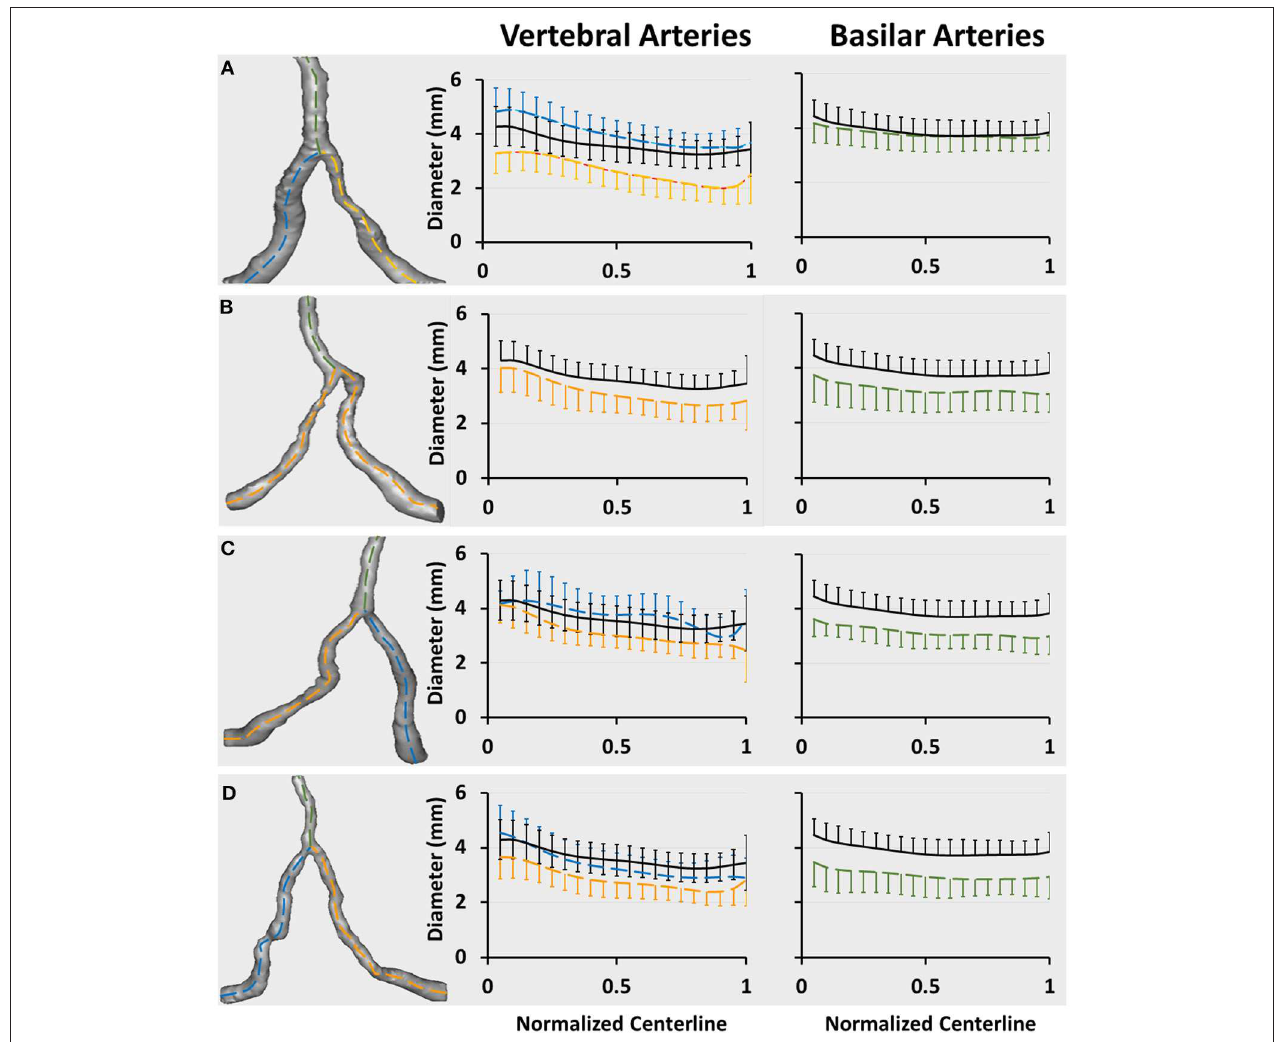
FIGURE 3 | Vertebrobasilar arteries reconstructed from patient CTA images in the stenotic group and a plot of D fit along normalized vertebral artery and basilar artery centerlines in (A) unilateral (31 patients), (B) bilateral (21 patients), (C) bifurcation (11 patients), and (D) tandem (37 patients) stenotic sub-groups. The black line refers to the mean value of D fit (averaged over 74 patients) in the symmetric group. The blue and yellow lines in Figures A,C,D refer to the mean value of D fit along normalized vertebral arteries of large and small sizes, respectively. The yellow line in Figure B refer to the mean value of D fit along the normalized vertebral artery given similar sizes between left and right vertebral arteries. The green line refers to the mean value of D fit along the normalized basilar artery. The error bars refer to the standard deviation.